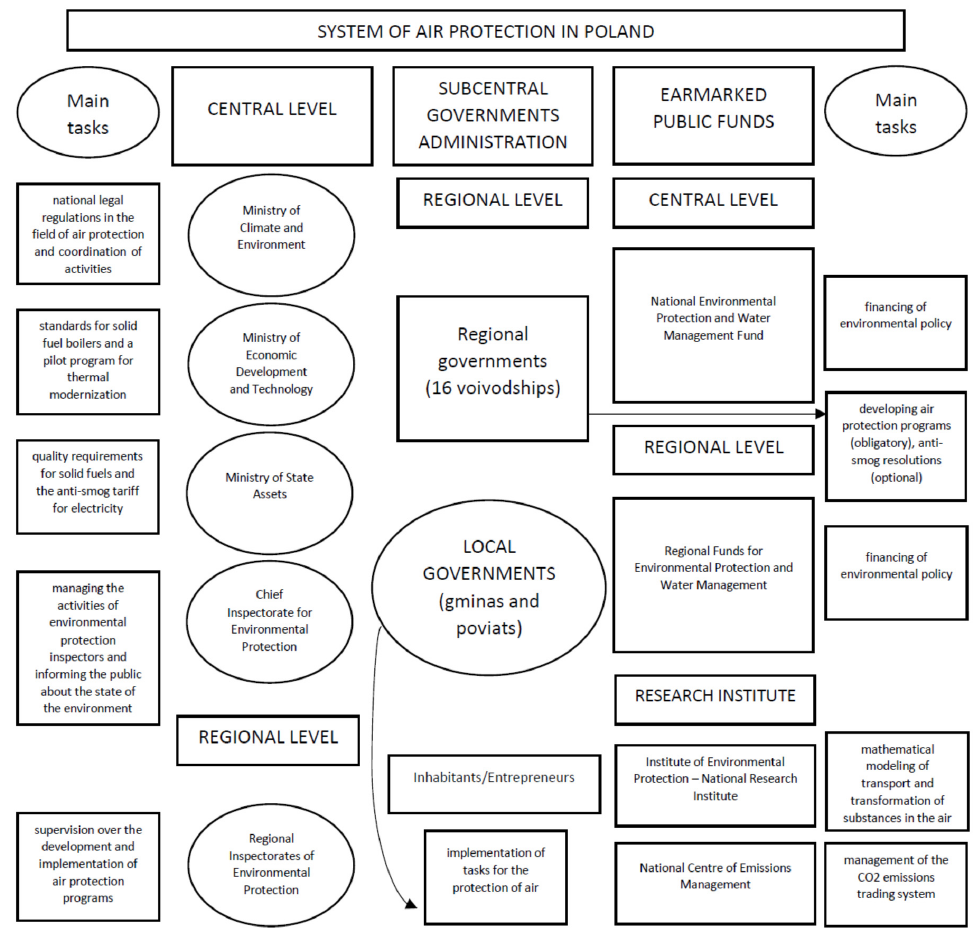
Figure 1. The Polish system of air protection against pollution. Source: Informacja o wynikach kontroli “Ochrona powietrza przed zanieczyszczeniami”/Information on the results of the inspection “Protection of air against pollution.” Najwy ż sza Izba Kontroli/Supreme Audit Office: Warszawa, Poland, 2018, p. 73. (In Polish). Available online: https://www.nik.gov.pl/kontrole/P/17/078/ (accessed on 29 August 2021).